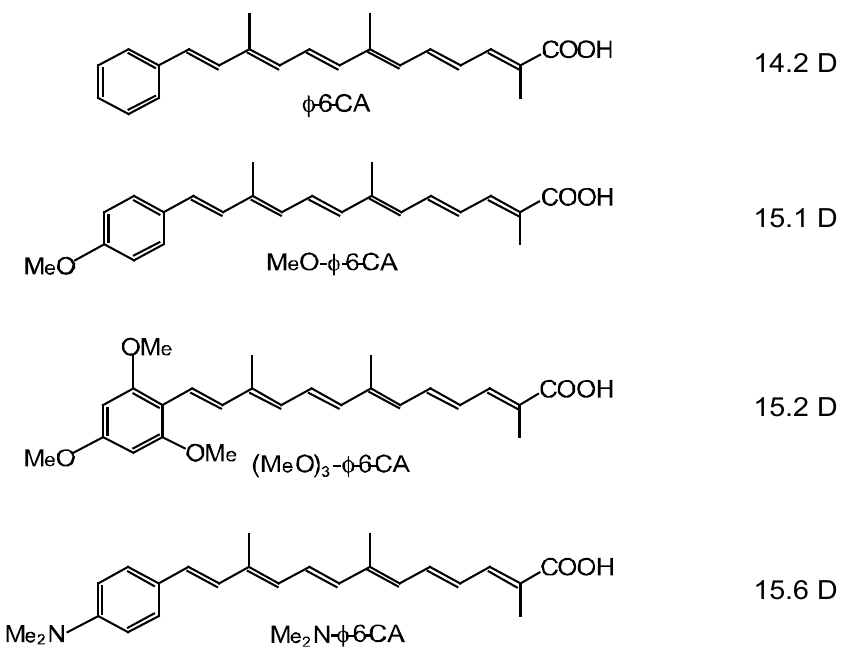
Figure 12. Chemical structures of a set of four polyene sensitizers with the increasing polarizability and, as a result, the increasing tendency of aggregate formation (reprinted from [8] with permission of Elsevier).